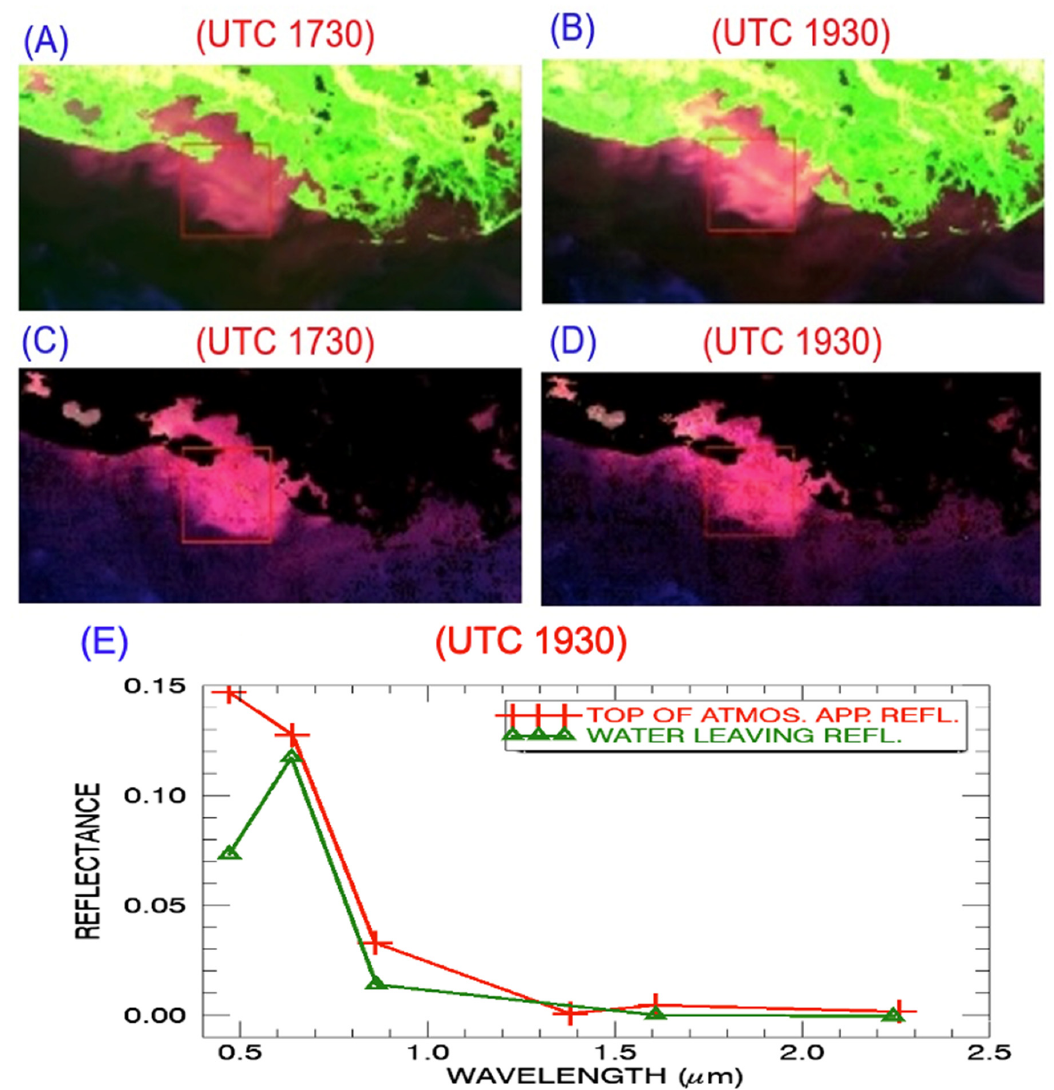
Figure 5. ( A , B ): false color ABI images acquired at UTC 1730 and 1930, respectively on March 20, 2019 near the Gulf of Mexico; ( C , D ): the corresponding derived water surface reflectance images; ( E ): spectral plot for a pixel before and after atmospheric corrections.